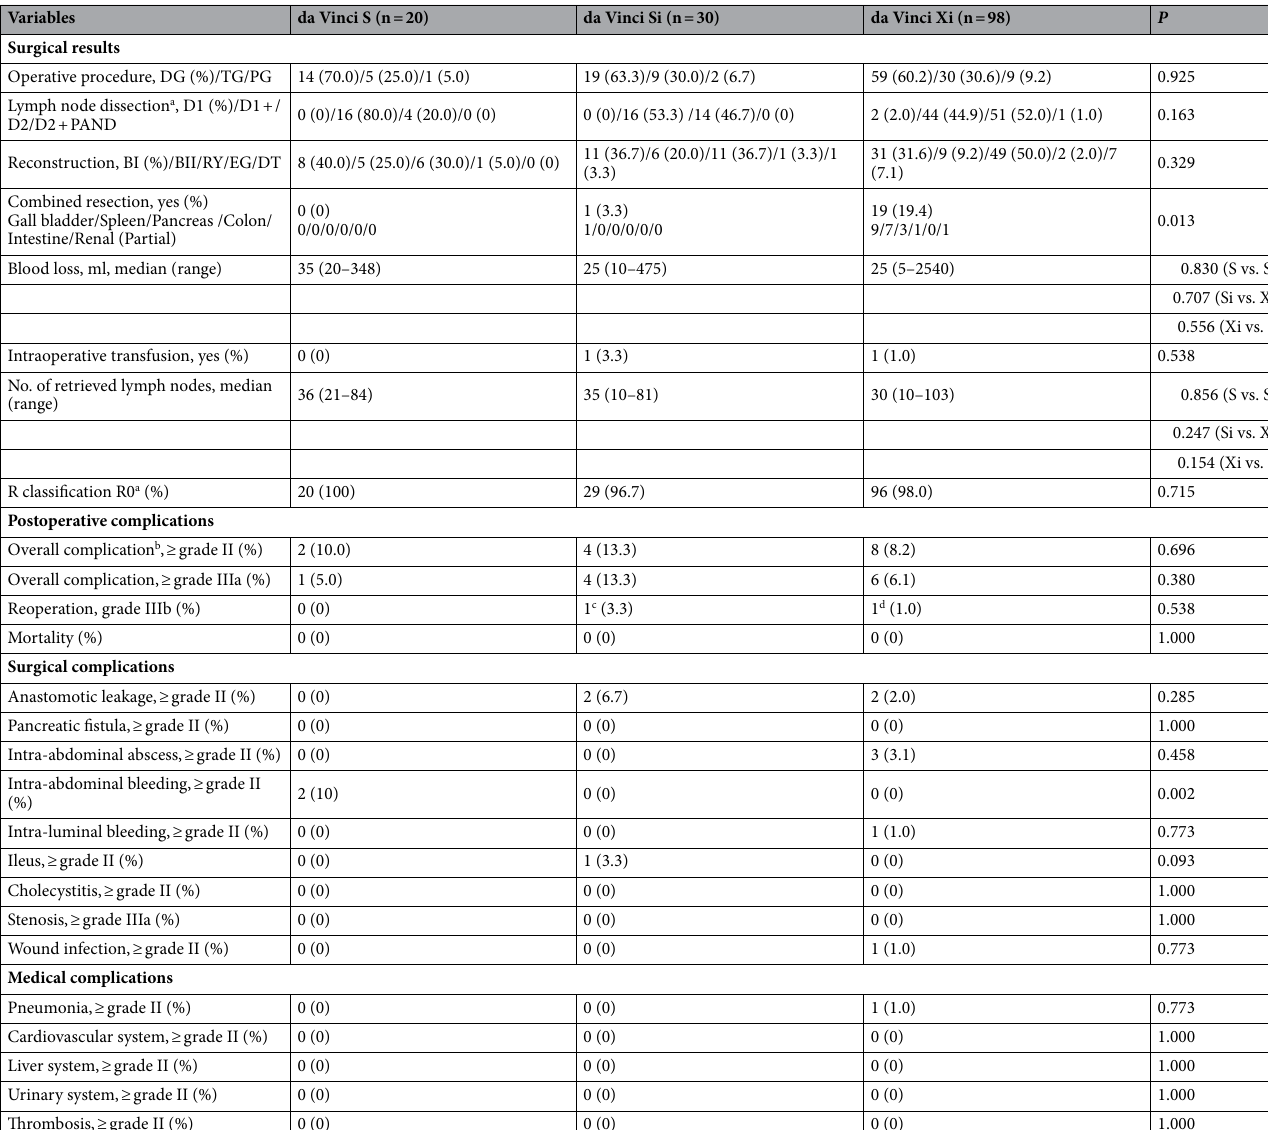
Table 3. Surgical results and postoperative complications. DG distal gastrectomy; TG total gastrectomy; PG proximal gastrectomy; PAND para-aortic nodal dissection; BI Billroth-I reconstruction; BII